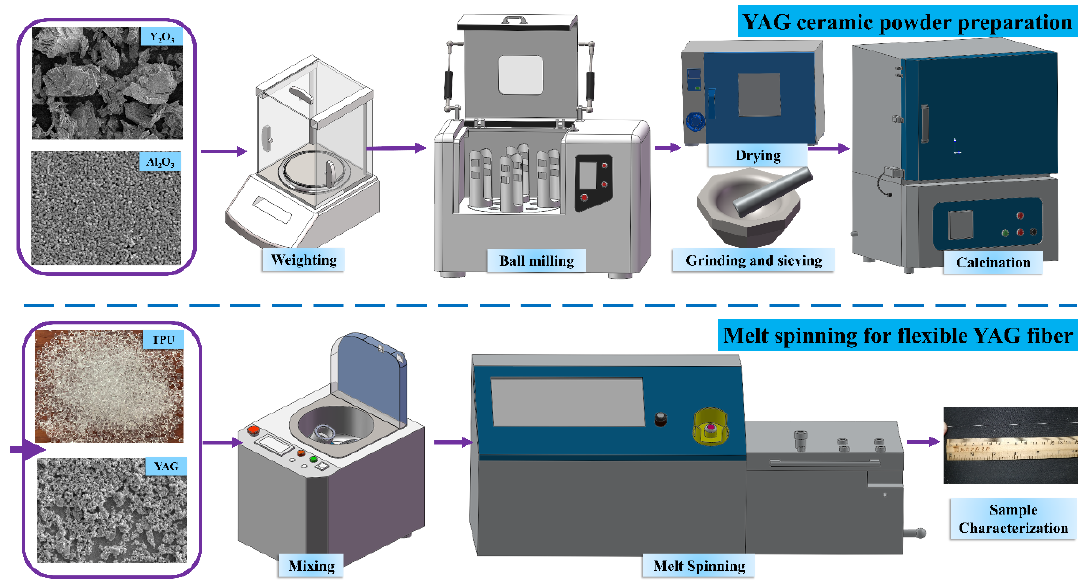
Figure 1. Process of preparing the flexible green body of YAG ceramic fiber by melt spinning.